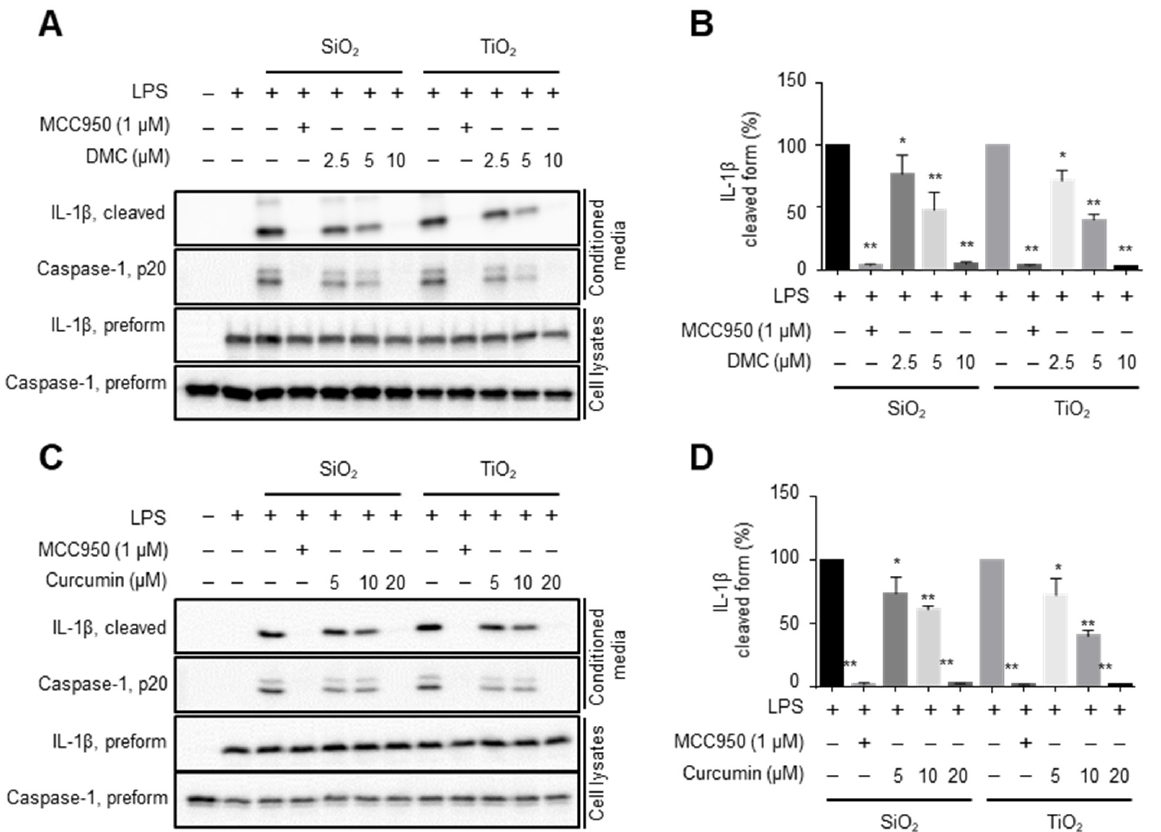
Figure 3. DMC and curcumin are active ingredients in C. phaeocaulis extract. Bone marrow-derived mononuclear cells were differentiated into macrophages. The cells were primed with lipopolysac- charide and treated with either SiO 2 or TiO 2 to activate inflammasome. The effects of DMC on the activation of inflammasome was determined by analyzing the levels of the secreted IL-1 β and caspase-1 (p20) active forms in cultured media by Western blot ( A ). Data from three independent replicates are shown for cleaved IL-1 β as bar graphs ( B ). The effects of curcumin on the activation of inflammasome was determined by analyzing the levels of the secreted IL-1 β and caspase-1 (p20) active forms in cultured media by Western blot ( C ). Data from three independent replicates are shown for cleaved IL-1 β as bar graphs ( D ). Data are expressed as mean ± SD, and different symbols indicate differences at * p < 0.05, ** p < 0.001 vs. LPS + SiO 2 or LPS + TiO 2 group.